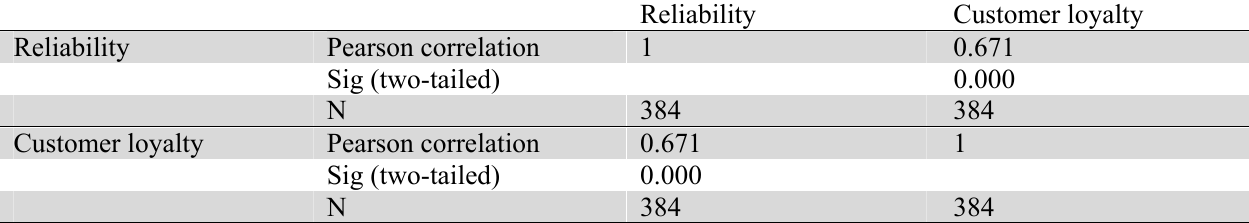
The result of Pearson correlation ratios Reliability